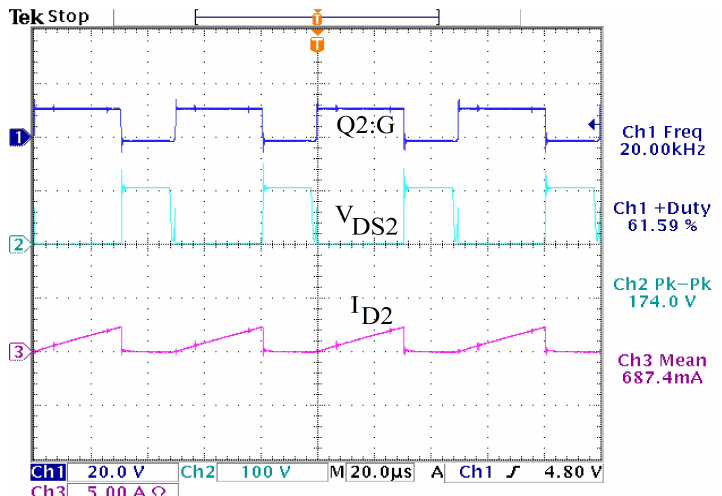
Figure 16. Switch stresses of Q2.